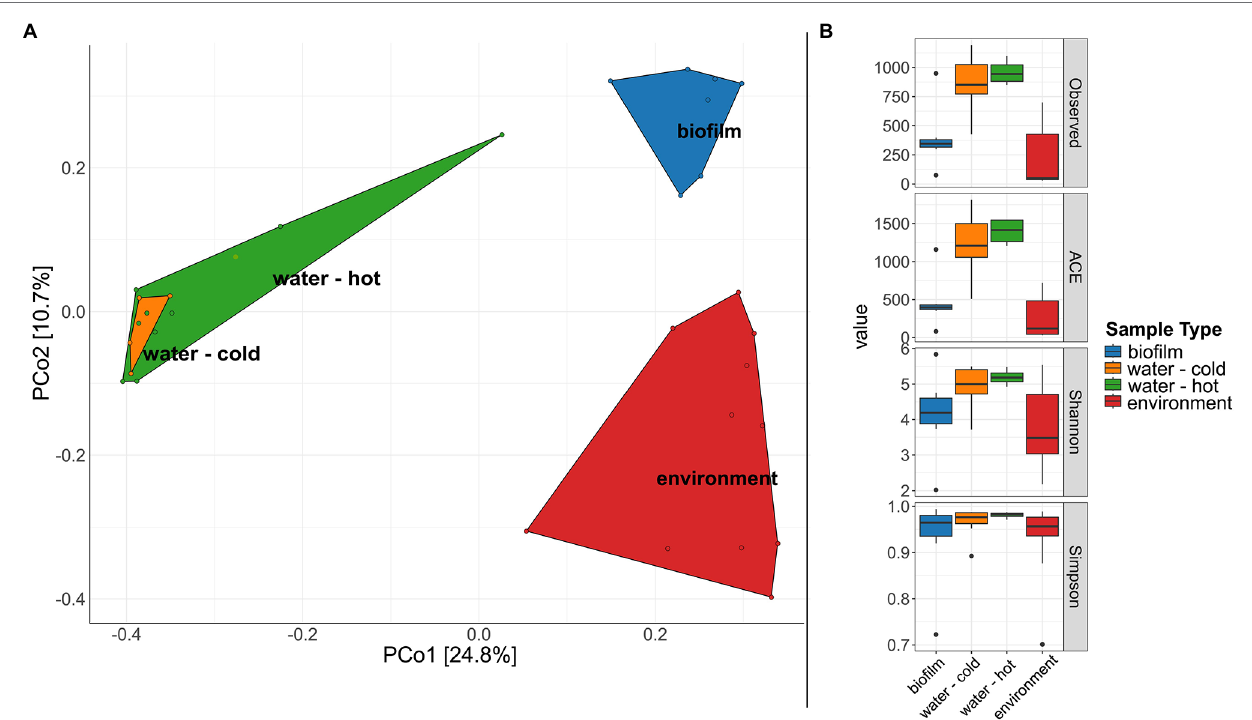
FIGURE 6 | Diversity of microbial communities in water, water hoses, and in the environment. (A) Principal coordinates analysis (PCoA) plot showing clustering of different sample types. (B) Alpha diversity indices (Observed, ACE, Shannon, Simpson) for bacterial communities of the different sample types: biofilms from water hoses (blue), water [cold (orange) and hot (green)], and environmental samples